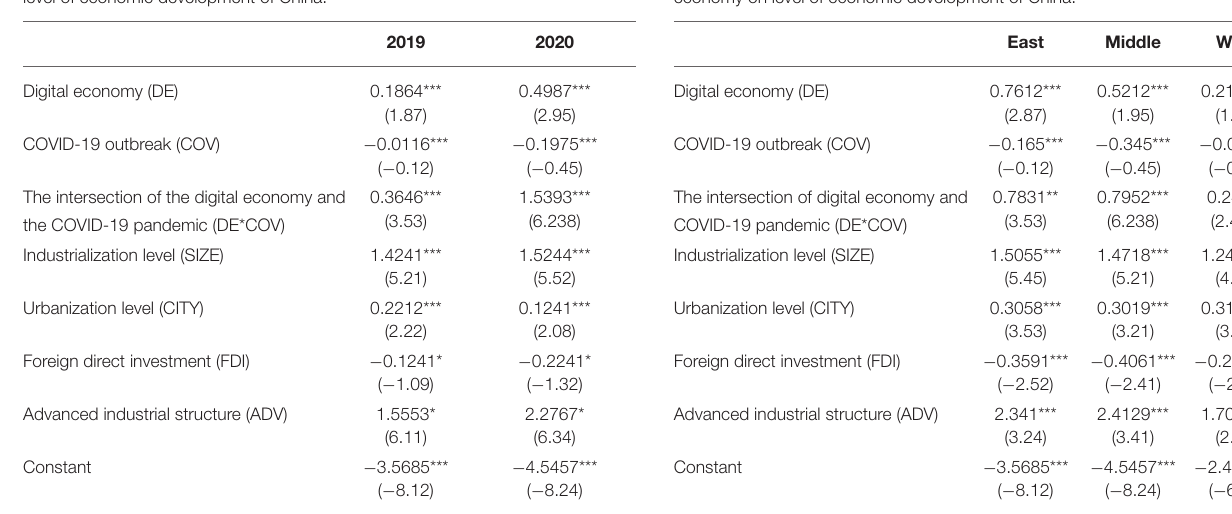
TABLE 6 | Regional heterogeneity of the impact of COVID-19 and the digital economy on level of economic development of